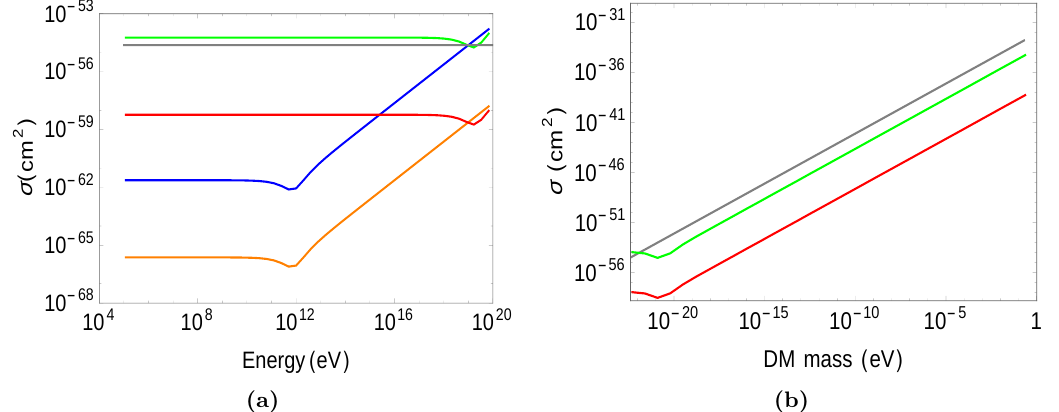
Figure 6. Fermion-mediated neutrino-DM scattering. (a) Cross-section vs. incoming neutrino energy. Green and blue lines represent cross-sections for m (cid:23) = 10 (cid:0) 2 ; 10 (cid:0) 5 eV respectively with m F = 10 GeV. Red and orange lines represent cross-sections for m (cid:23) = 10 (cid:0) 2 ; 10 (cid:0) 5 eV respectively with m F = 100 GeV. Here C L = 0 : 88, m DM = 10 (cid:0) 22 eV. (b) Cross-section vs. mass of DM. Green and red lines represent m F = 10 ; 100 GeV respectively for m (cid:23) = 10 (cid:0) 2 eV. Here C L = 0 : 88, E (cid:23) = 1 PeV. Grey line represents the required cross-section to induce 1% suppression of incoming neutrino